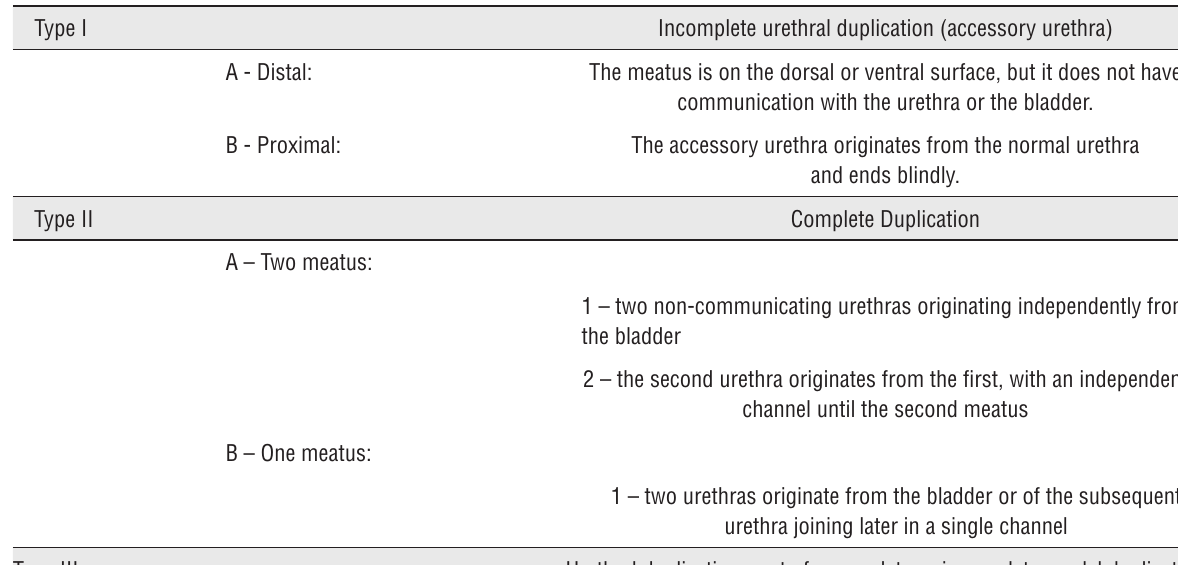
Table 1 - classification of urethral duplication (Effmann et al.,